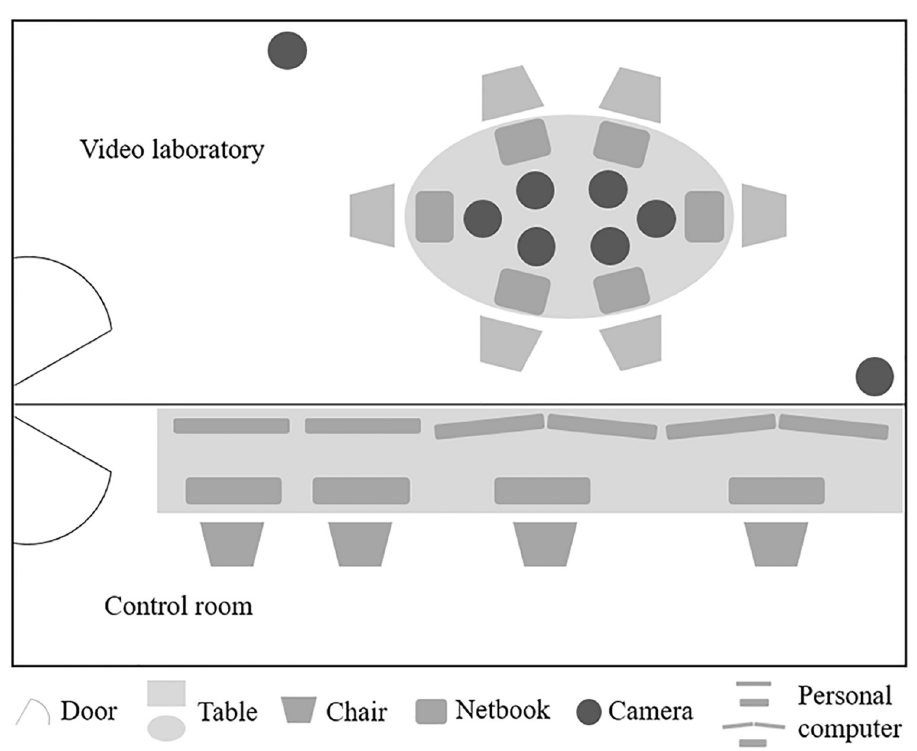
Fig 3. Schematic overview of the video laboratory and control room in